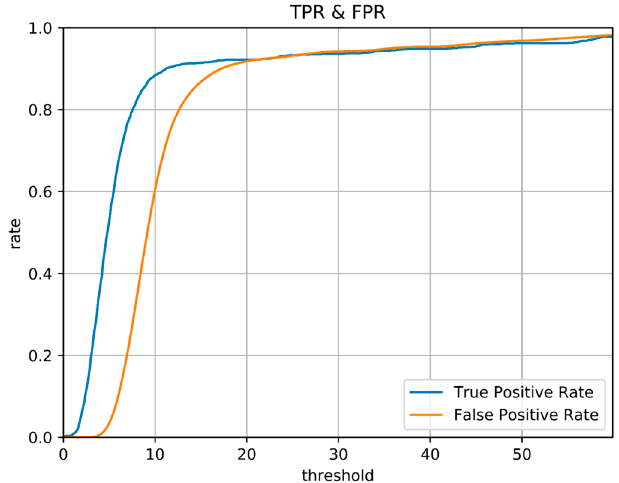
Figure 6. True positive Rate and False Positive Rate of different threshold.